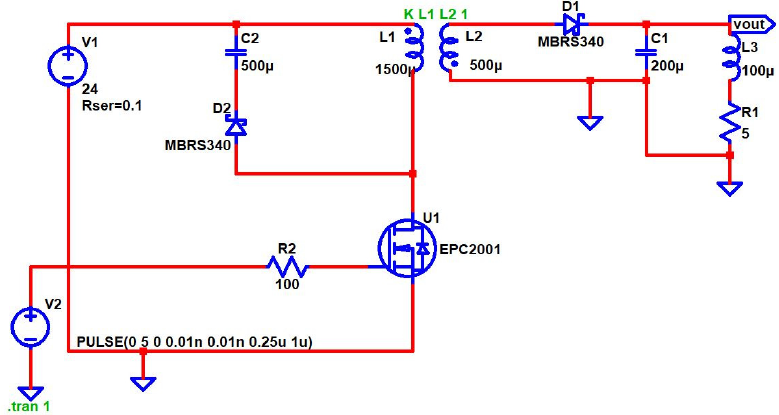
Figure 16. GaN-switch-based DC-to-DC flyback converter with RLC load configuration.